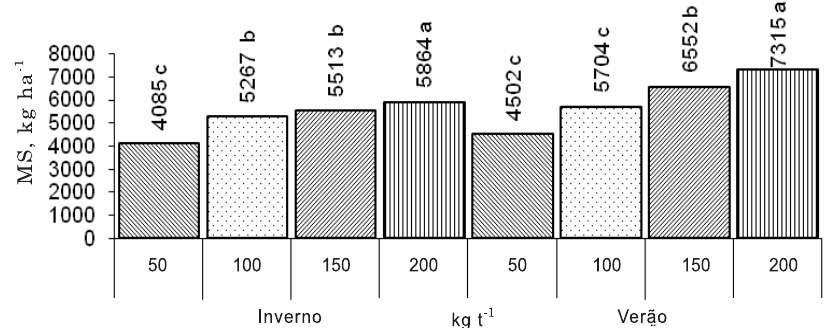
Figura 8. Produção de matéria seca pré-pastejo do capim-Marandu, submetidas a quatro ofertas de forragem durante o verão e inverno. Médias acompanhadas de mesma letra, na estação, não diferem estatisticamente entre si pelo teste de Tukey.